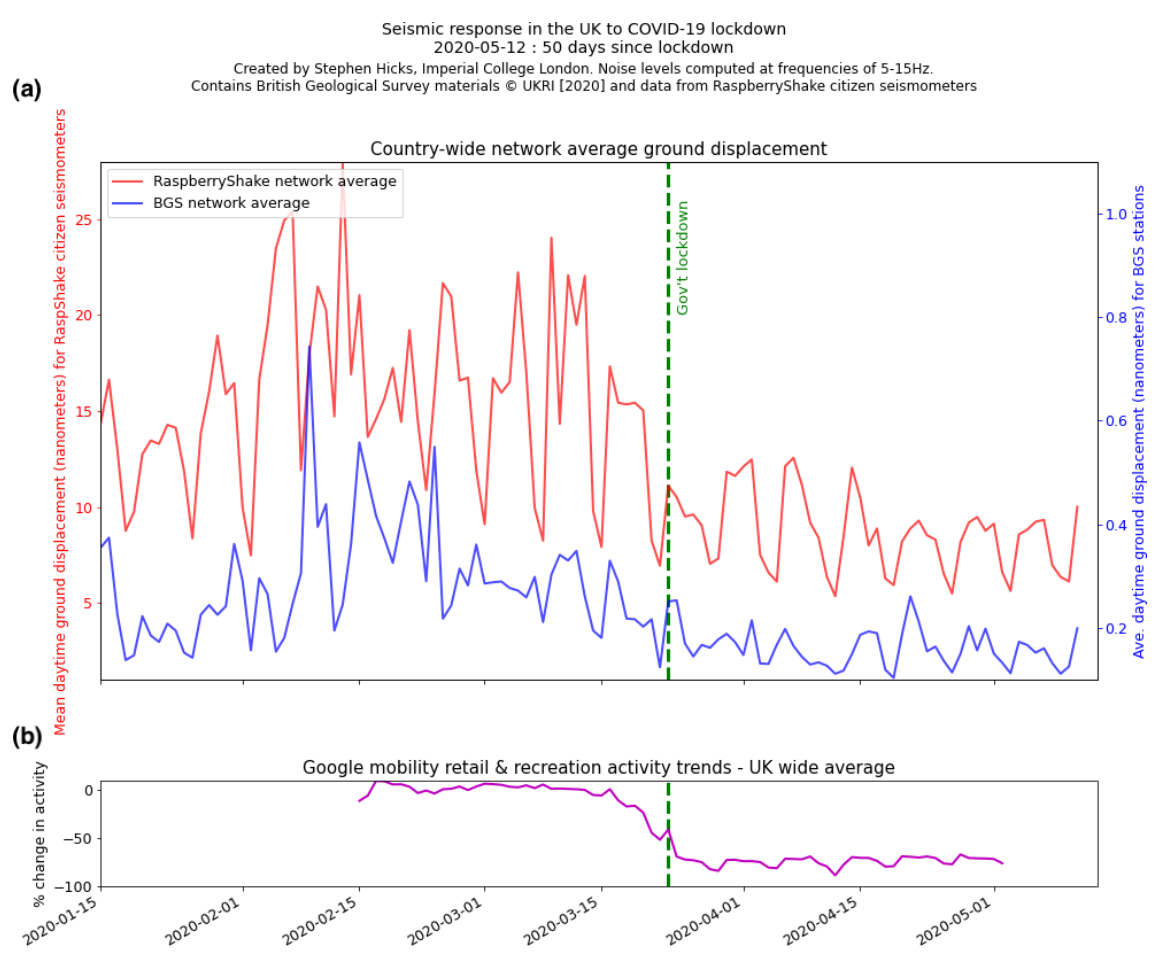
Figure 15. (a) Plot of average seismic noise recorded in the UK by the British Geological Survey (BGS) seismic network (blue) and the Raspberry Shake (RS) network (red) shows a marked decrease in seismic noise levels on both networks since the Covid-19 lockdown began on 23 March, 2020. This plot shows a decrease in average noise level of ∼ 0.6 and ∼ 15nm on the BGS and RS networks, respectively, between the peak noise levels in early February and the government lockdown in late March. (b) The Google mobility data also depict a similar decrease in activity in the UK associated with retail and recreation activity trends post-lockdown. This plot shows that UK recreation and retail activity dropped by ∼ 80% post-lockdown. Figure created by Stephen Hicks of Imperial College